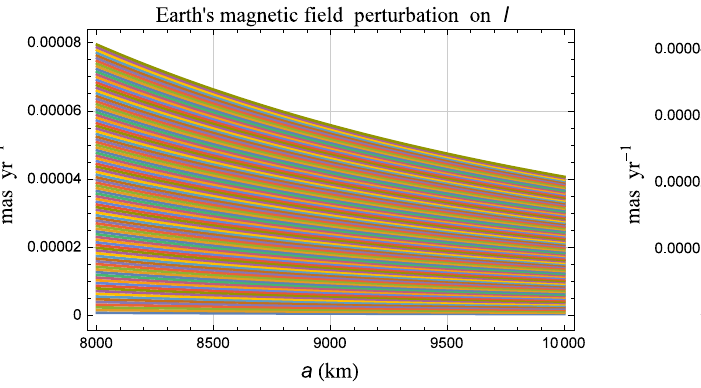
1 − 100 × 10 − 11 C admitted for LAGEOS [67]. A circular, polar orbit was adopted along with the mass of LAGEOS. The assumed relative uncertainty in the Earth’s magnetic dipole m ⊕ is 6 × 10 − 4 [20, Table